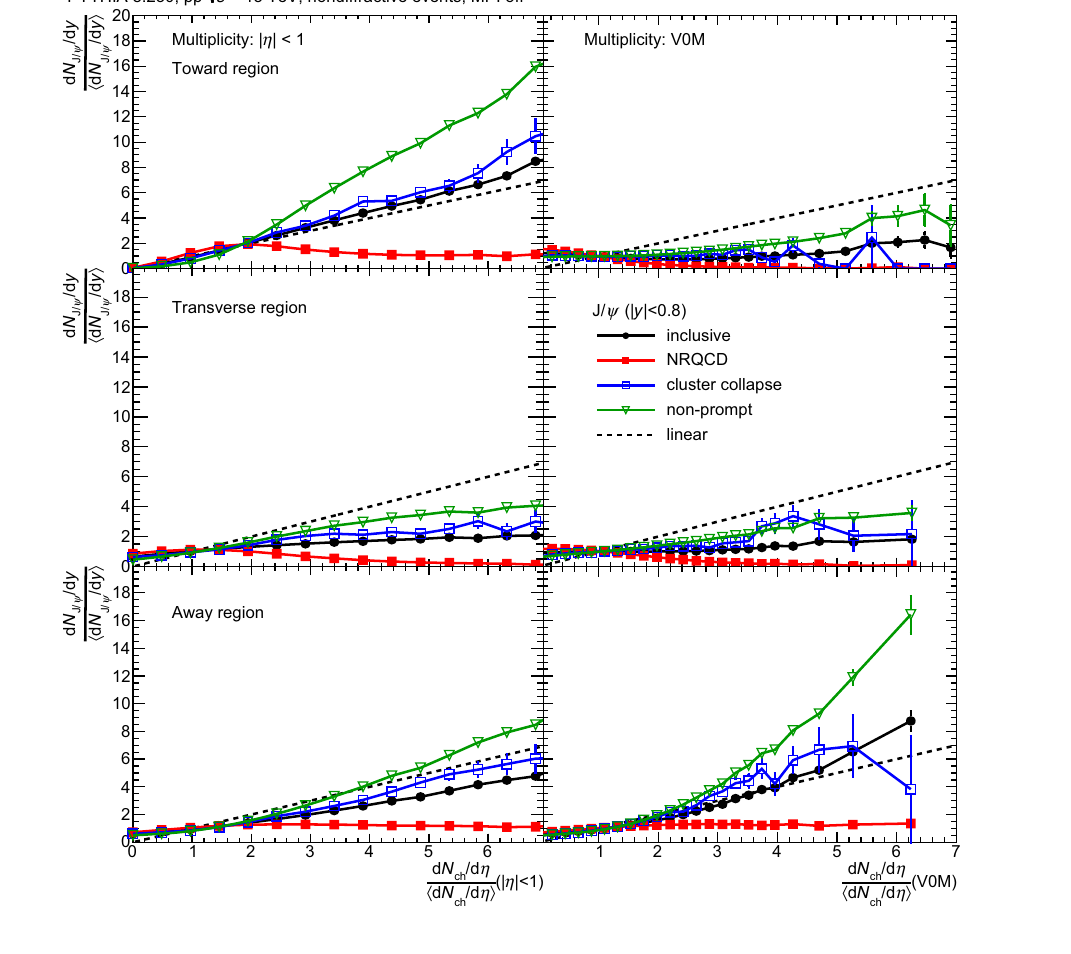
dependence of J /ψ produced at mid-rapidity in PYTHIA8.230 with multiparton interactions switched off, split into the different production processes. The different panels are for the multiplicity evaluated in different kinematic regions. Left: multiplicity at mid-rapidity, right: multiplicity at forward rapidity; top row: multiplicity in Toward region in ϕ w.r.t. J /ψ , middle row: multiplicity in Transverse region, bottom row: multiplicity in Away region